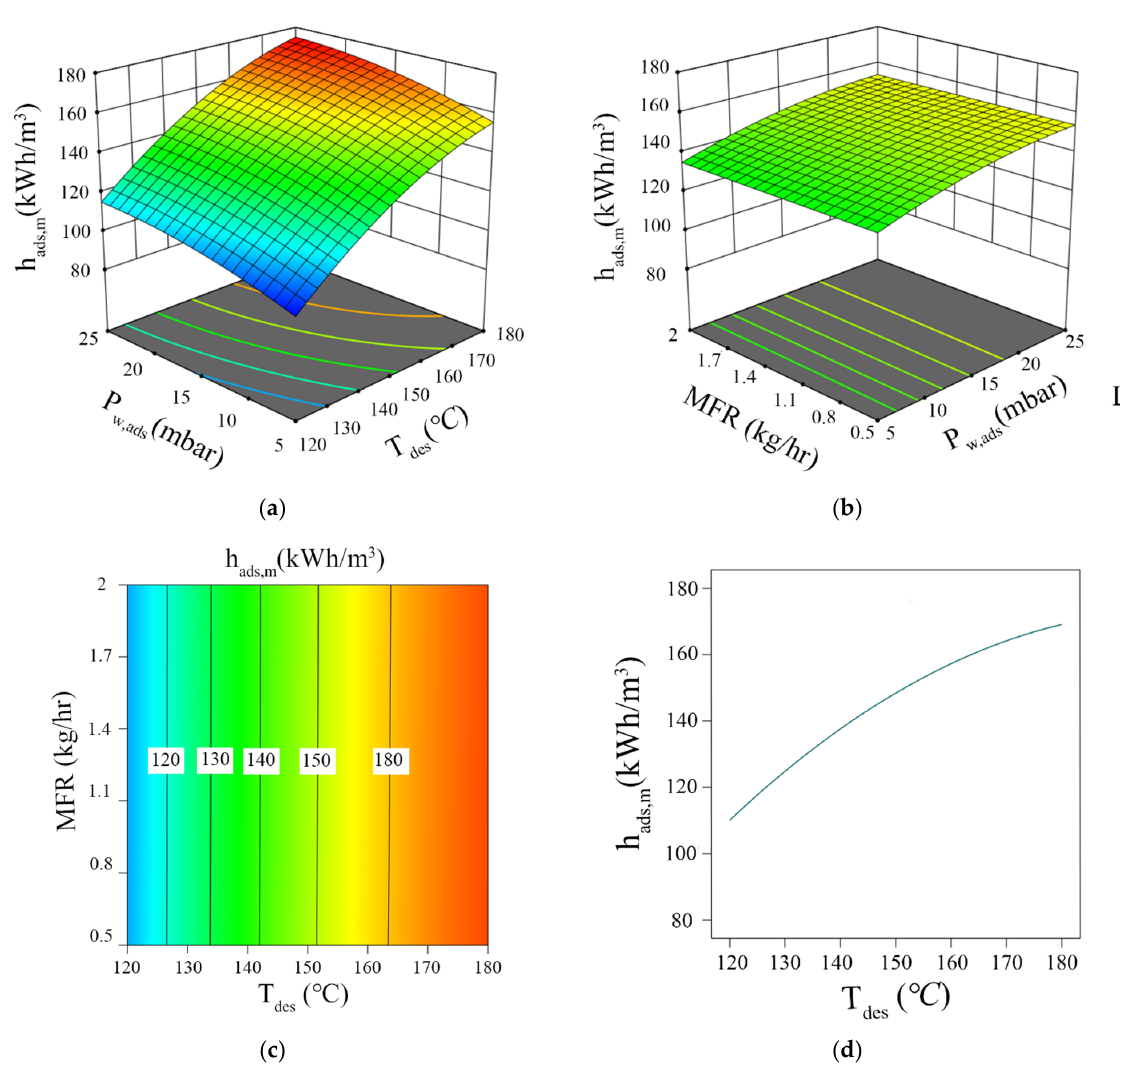
Figure 7. Variation of the mean specific adsorption enthalpy with ( a ) desorption temperature and partial pressure of water vapor ( b ) mass flow rate and partial pressure ( c ) desorption temperature and mass flow rate of the incoming air ( d ) desorption temperature.